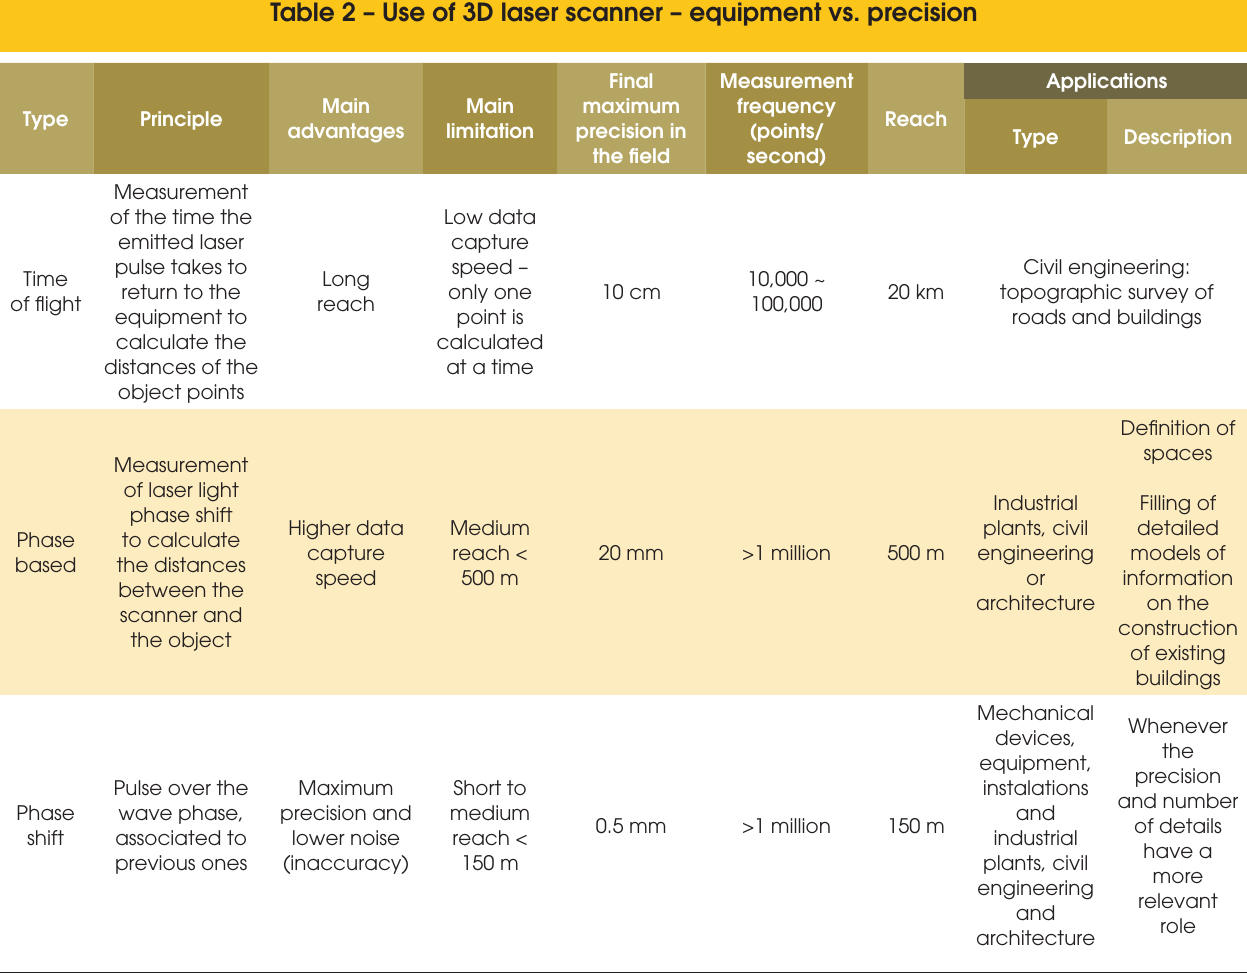
Table 2 – Use of 3D laser scanner – equipment vs.